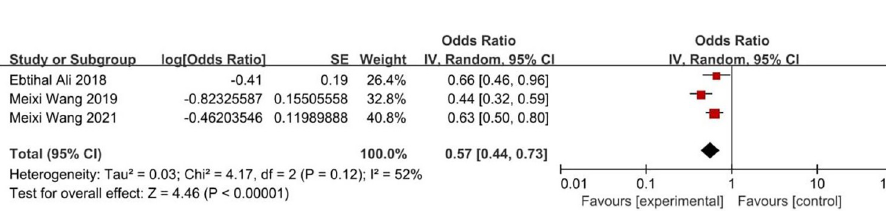
Fig 4. Forest diagram of the relationship between gestational age and the incidence of MBDP.